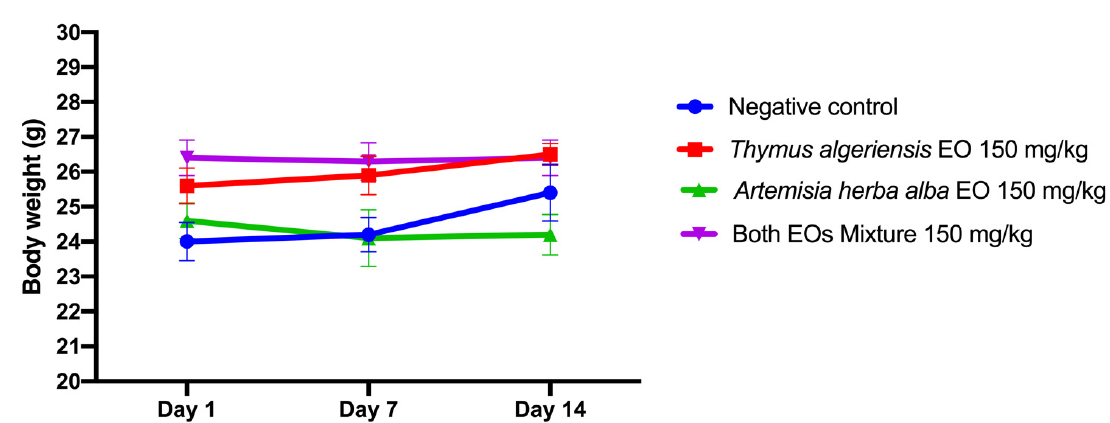
(Table 3). All animals survived after 14 days of testing. Their body weight remained al- most stable over time, and there was no significant difference in the variation in body weight between the treated mice and those of the control for 14 days (Figure 5). These results imply that the LD50 of this mixture is greater than 150 mg/kg, according to the Globally Harmonized System of Classification and Labeling of Chemicals.